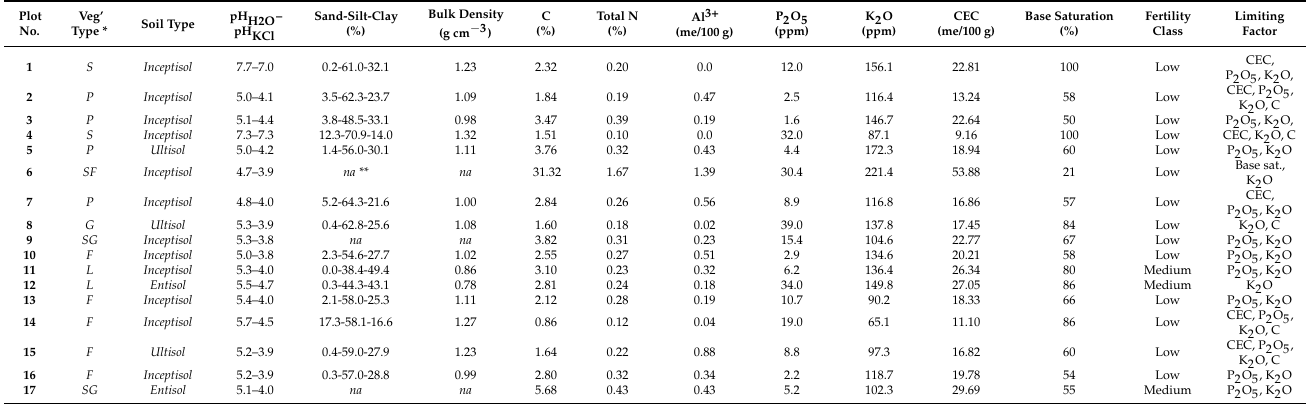
Table 6. Soil (0–20 cm) properties in the Mamberamo Basin by selected physical and chemical characteristics and fertility assessment. Plot